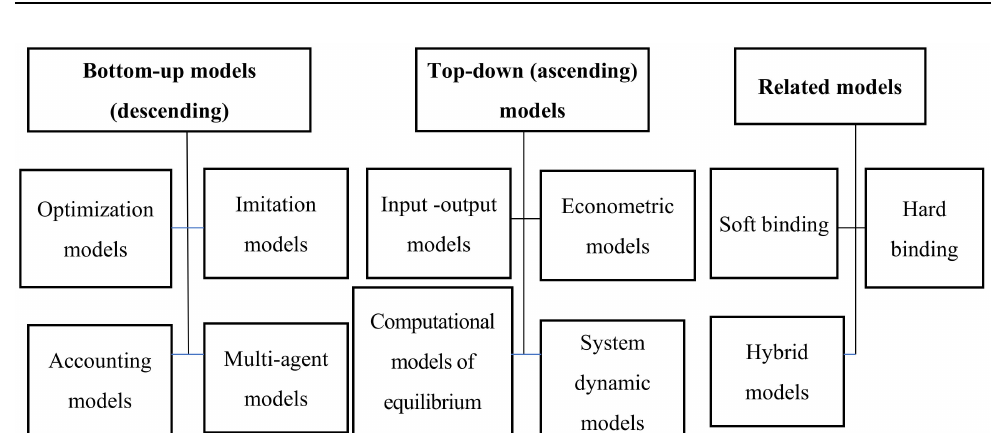
Figure 7. The classification of decarbonisation models focusses on the energy sector. Reprinted with permission from [42]. Copyright 2009, Boehringer, C.; Rutherford,